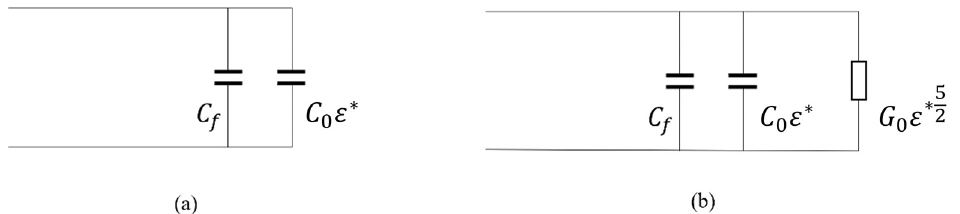
Figure 3. ( a ) Equivalent circuit of the S&S de-embedding model; ( b ) Equivalent circuit of the M&E de-embedding model.